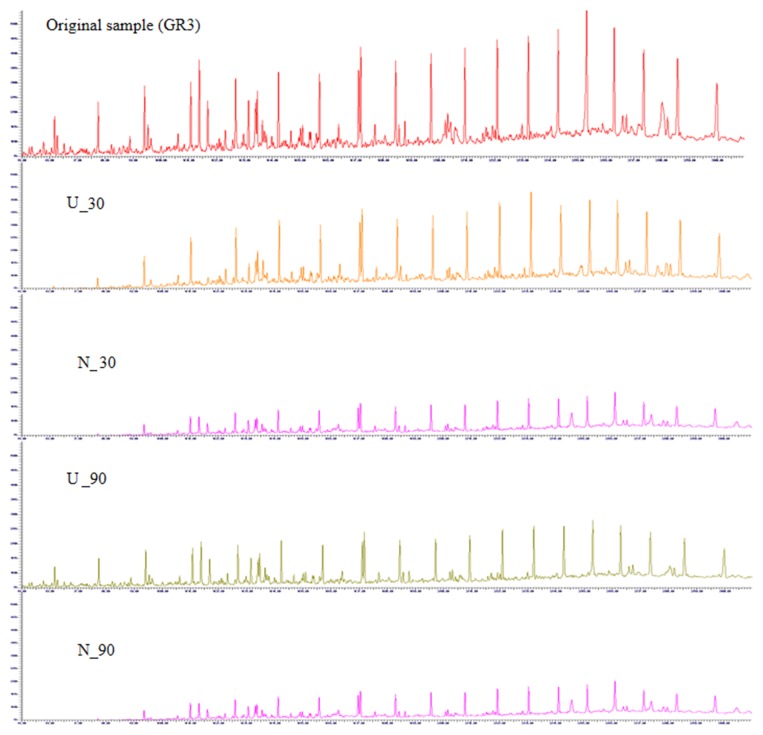
Gas chromatogram for GR3, U and N samples. GC-FID chromatograms showing constituent hydrocarbons after 30 and 90 days of microcosm incubation with or without nitrate amendment (U and N). Peaks have been assigned to carbon chain length corresponding to TPH standard (C10–28).